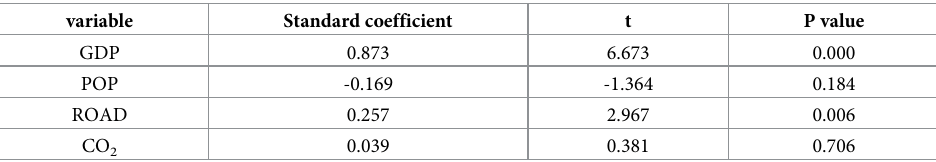
Table 2. Multiple regression coefficient at provincial level in